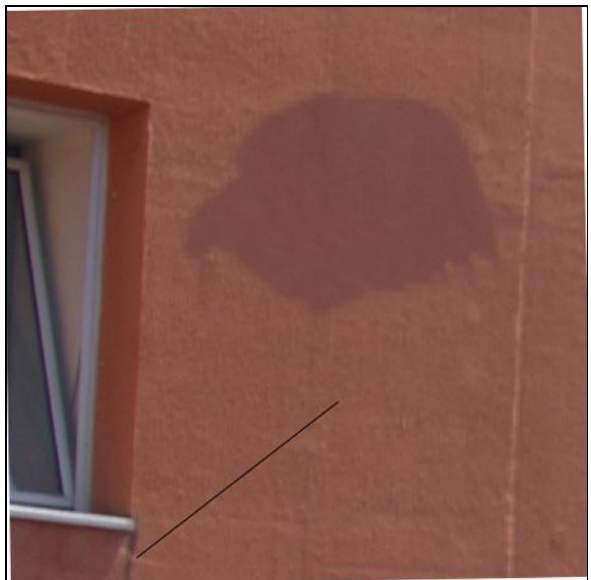
Figure 5. 3D view of image difference after radiometric shift and non maxima suppression